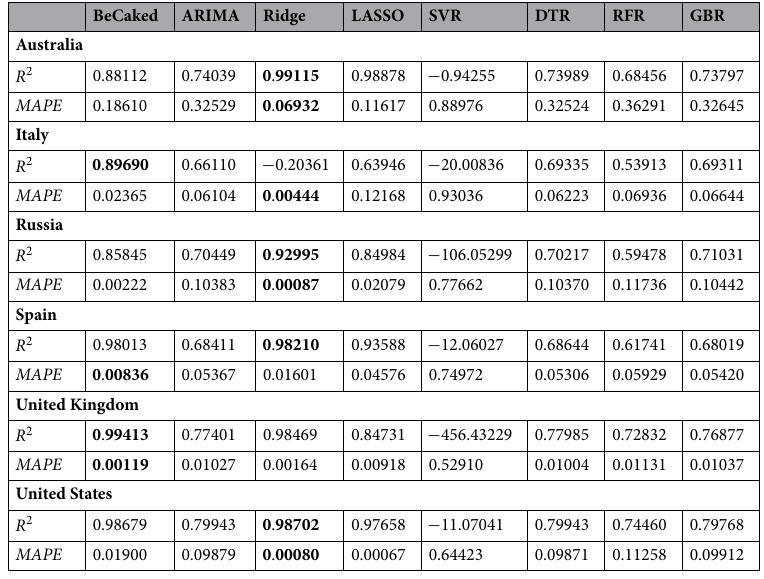
Table 5. Comparison of BeCaked and top-tier forecasting-specialized methods at country level with 7-step forecast. Best results are in [bold].